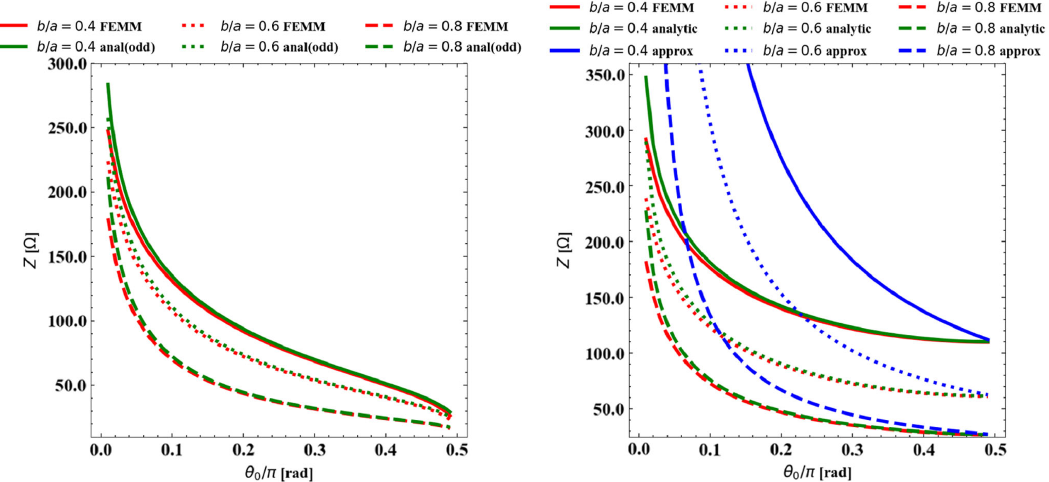
FIG. 11. Dipole kicker: Dependence of Z in the even mode on θ 0 calculated using FEMM, the analytic expression in Eq. (2.55) and c also the approximate form in Eq. (4.3) for different values of b=a